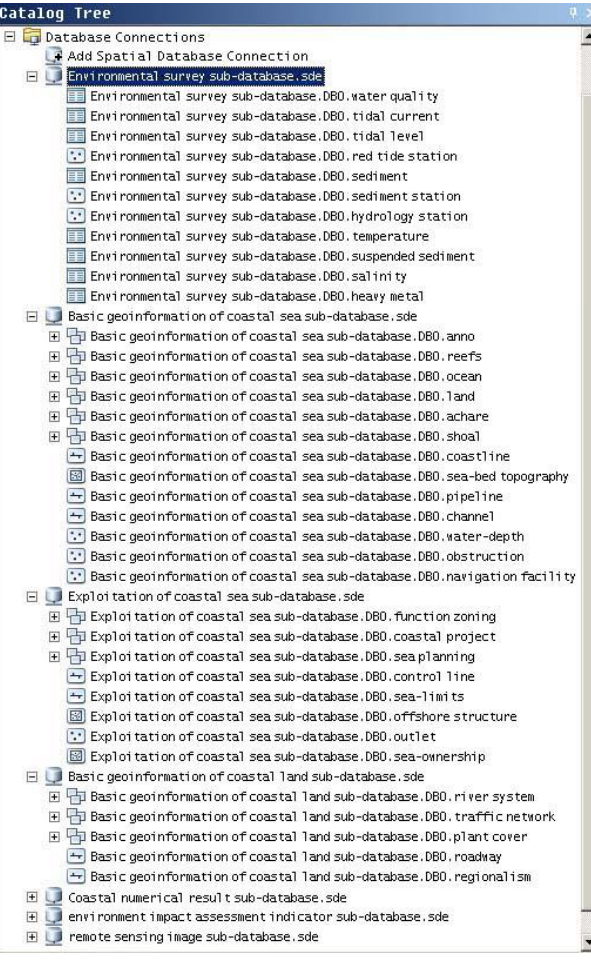
Figure 3. Physical storage structure of the coastal-zone spatial database.